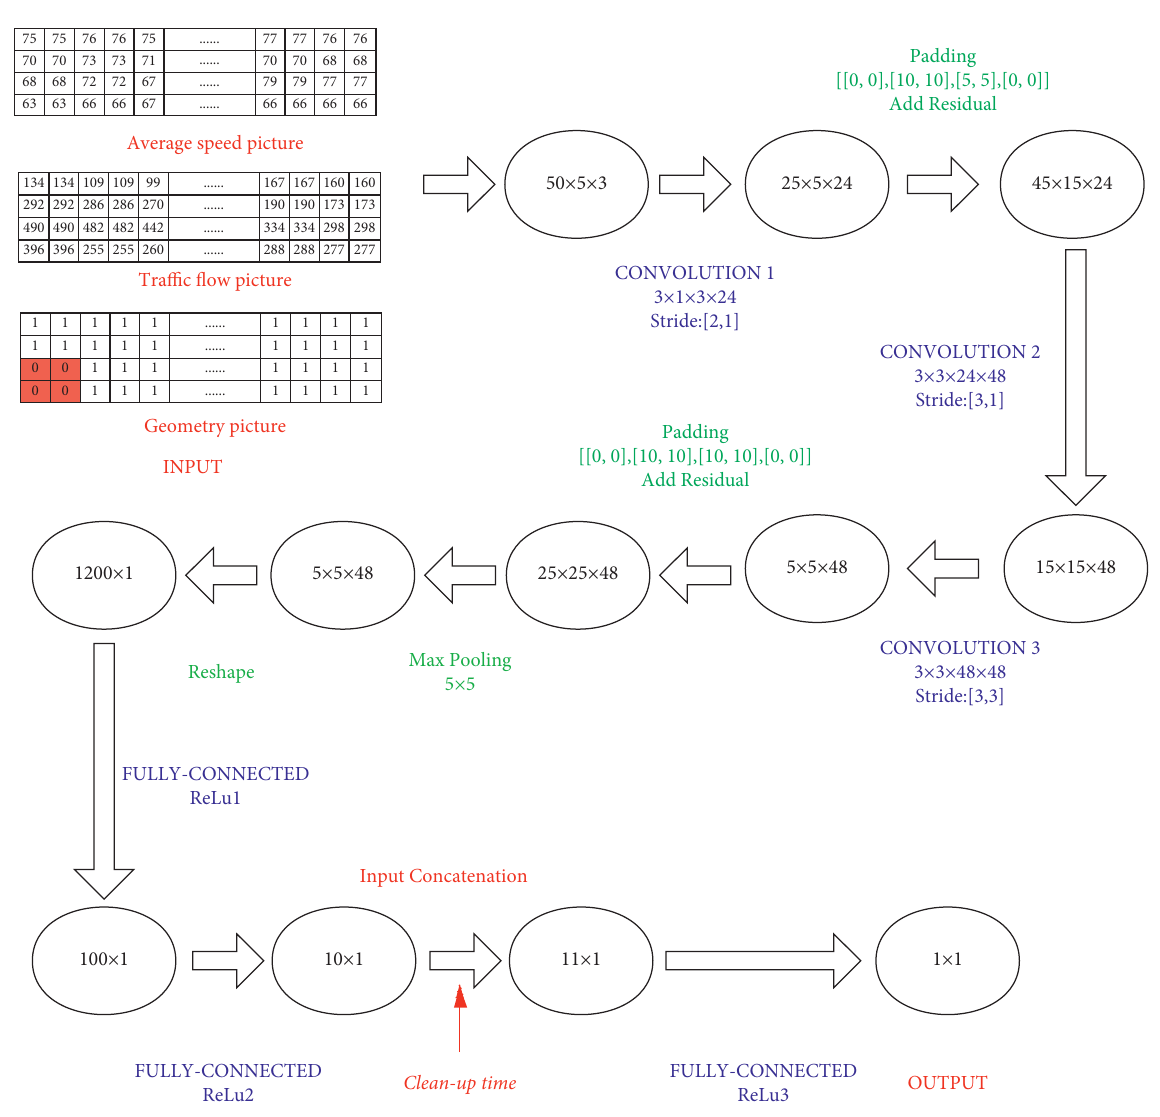
Figure 8: Structure of the CNNs in the 5-lane